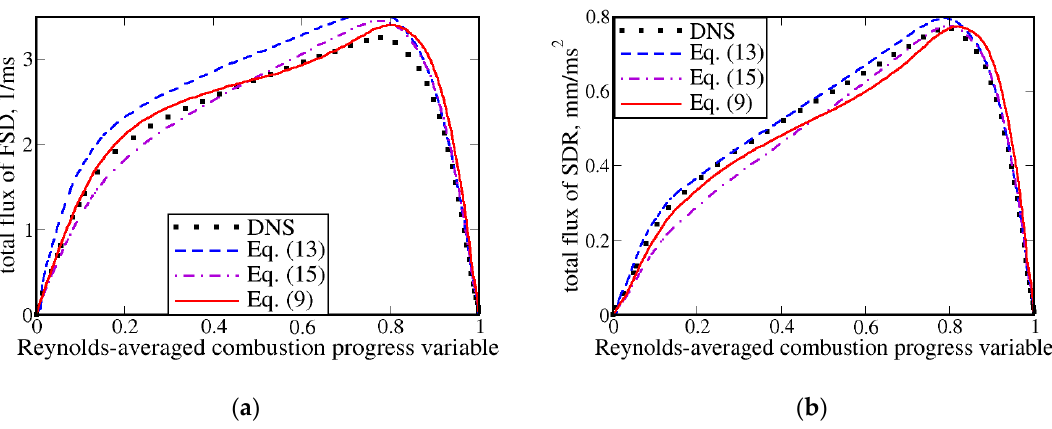
Figure 1. Total axial fluxes of ( a ) flame surface density (FSD) Σ and ( b ) scalar dissipation rate (SDR) χ . Case H.